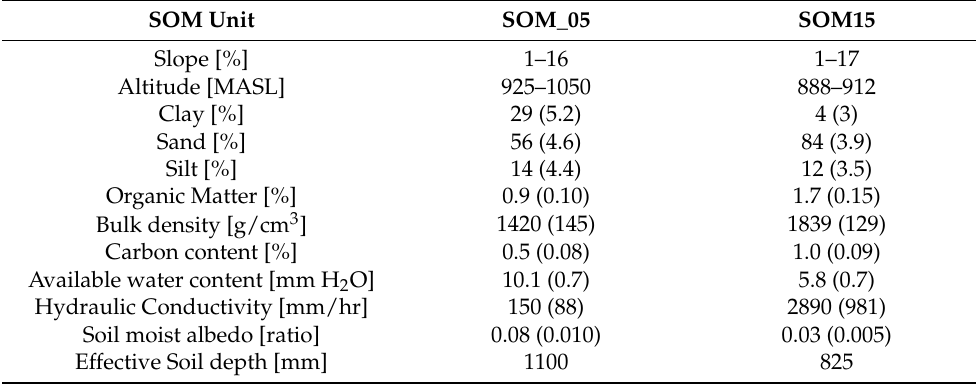
Table 1. Soil and topographic characteristics of Self-Organizing soil units SOM5 and SOM15 in the midlands of Eresma-Adaja basin. The deviation is showed in round